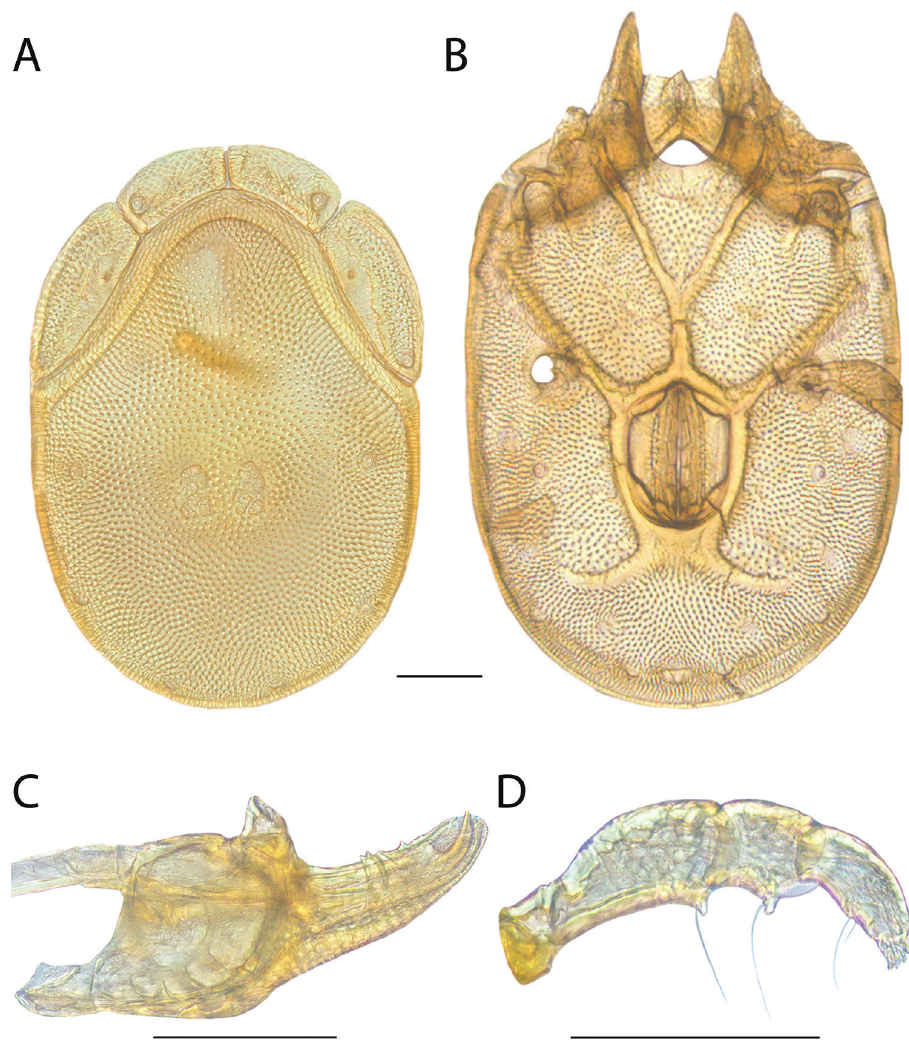
Figure 110. Torrenticola karambita sp. n. male: A dorsal plates B venter (legs removed) C subcapitulum D pedipalp (setae not accurately depicted). Scale = 100